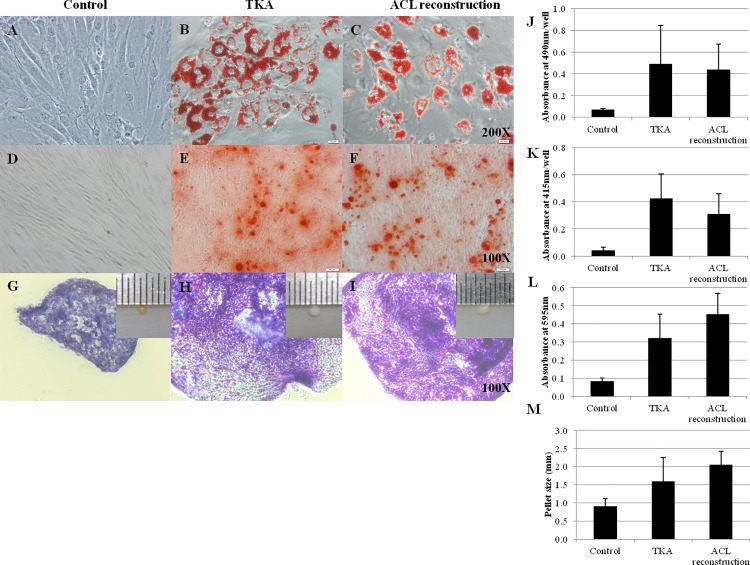
Adipogenic, osteogenic, and chondrogenic potentials of TKA and ACL reconstruction cultures in vitro.(A) Cells were cultured in control medium (A, D, G), adipogenic medium (B, C), osteogenic medium (E, F) or chondrogenic medium (H, I). Adipogenesis was evaluated by staining cells with Oil Red O and quantifying absorbance at 490nm (J). Osteogenesis was evaluated by staining cells with Alizarin Red S and quantifying absorbance at 415nm (K). Chondrogenesis was evaluated by staining cells with Toluidine Blue O and quantifying absorbance at 595nm (L). Chondrogenic pellet size was measured with a 1-mm scaled ruler (M). All data shown were the results of n≥3 per group.